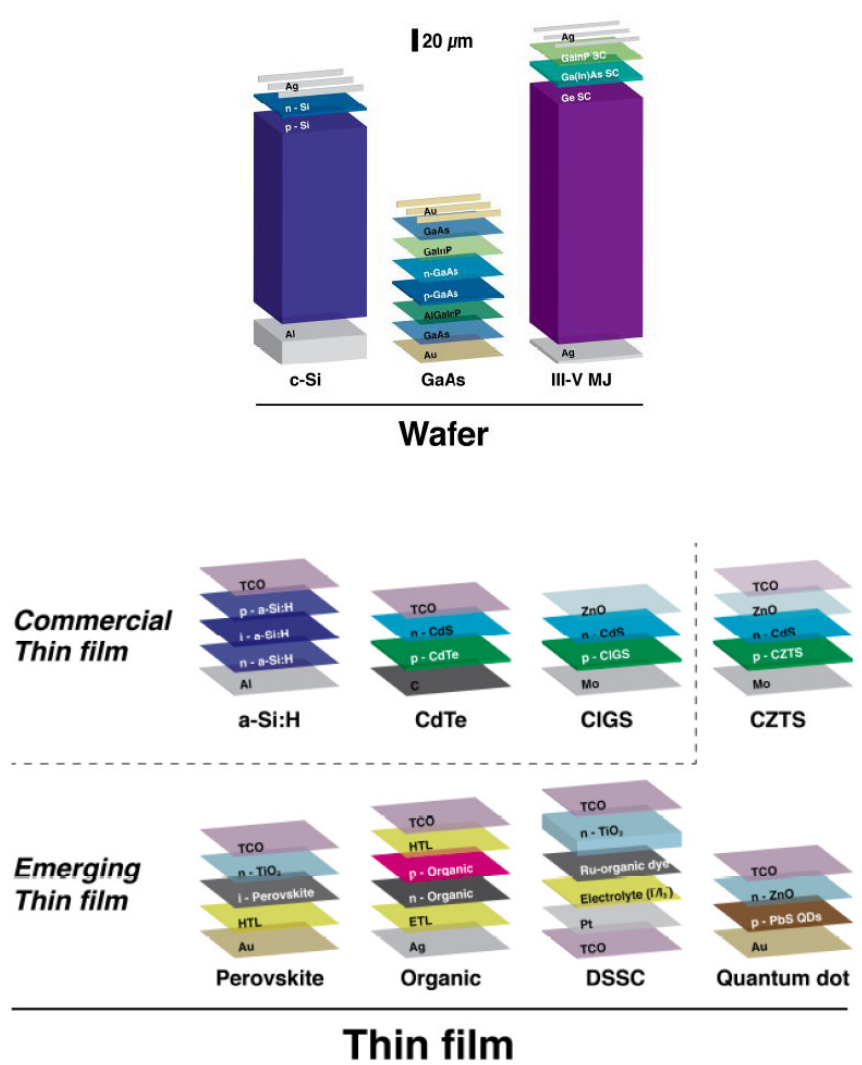
Fig. 9. – Typical solar PV device structures, divided into wafer-based and thin-film technologies. Primary absorber layers are labeled in white, and thicknesses are shown to scale. c-Si encom- passes sc-Si and mc-Si technologies. GaAs cells use thin absorbing films but require wafers as templates for crystal growth. For III-V multijunctions, sub-cells are shown for the industry- standard GaInP/Ga(In)As/Ge triple-junction cell, and some interface layers are omitted for simplicity. A representative single-junction a-Si:H PV structure is shown here, although PV performance parameters used elsewhere correspond to an a-Si:H/nc-Si:H/nc-Si:H triple-junction cell. Front contact grids are omitted for thin-film technologies since the metals used for those grids do not directly contact the active layers and are thus more fungible than those used for wafer-based technologies. The figure is taken from ref.